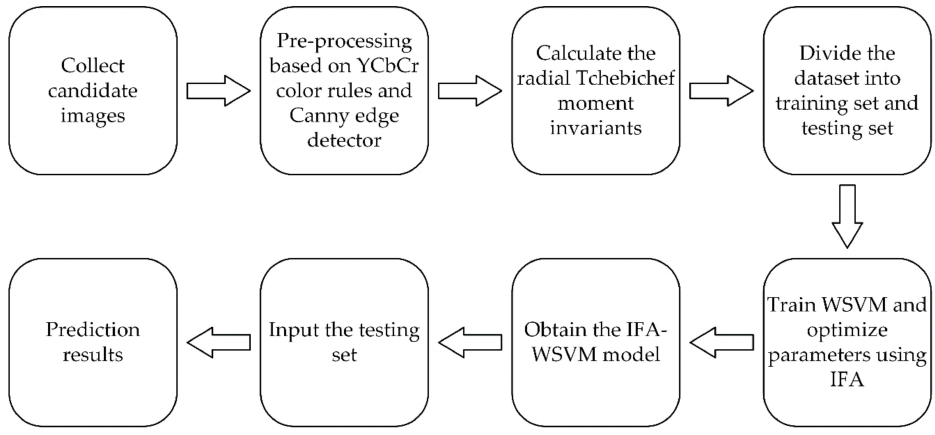
Figure 2. The flow diagram of combustion state recognition based on IFA-WSVM